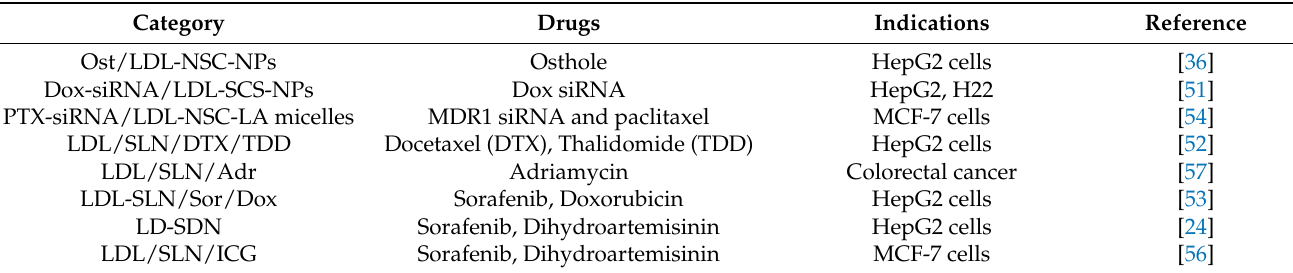
Table 4. LDL-NPs and